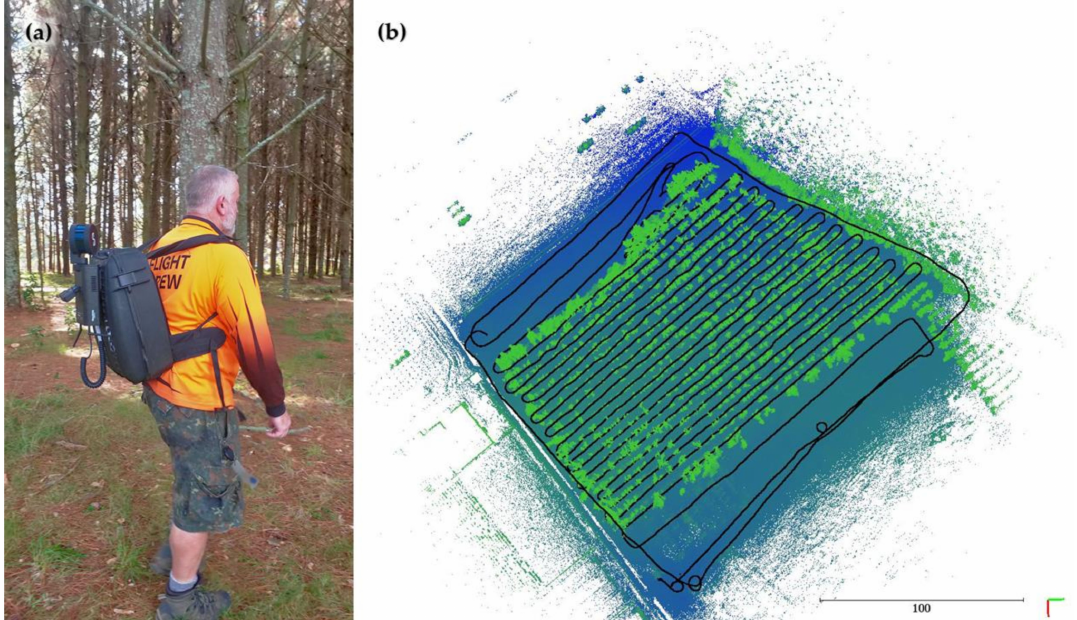
Figure 4. The Hovermap MLS in use ( a ) and ( b ) the trajectory of the MLS (in black) overlaid on stem locations within the trial, coloured by height (blue = low, green =